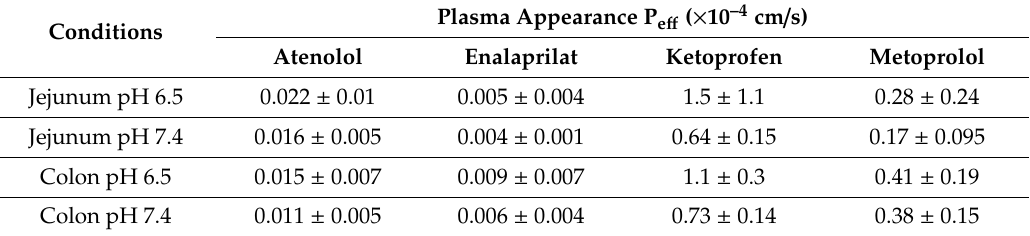
Table 2. The mean ±SD rat permeability (P eff ) values for the four model compounds determined in the jejunum and colon at pH 6.5 and 7.4 ( n = 6).